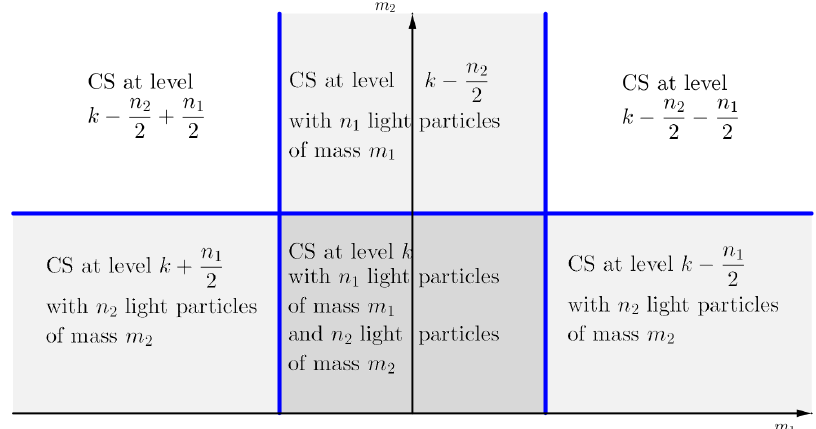
) -plane, cf. figure 12. 1 , m 2